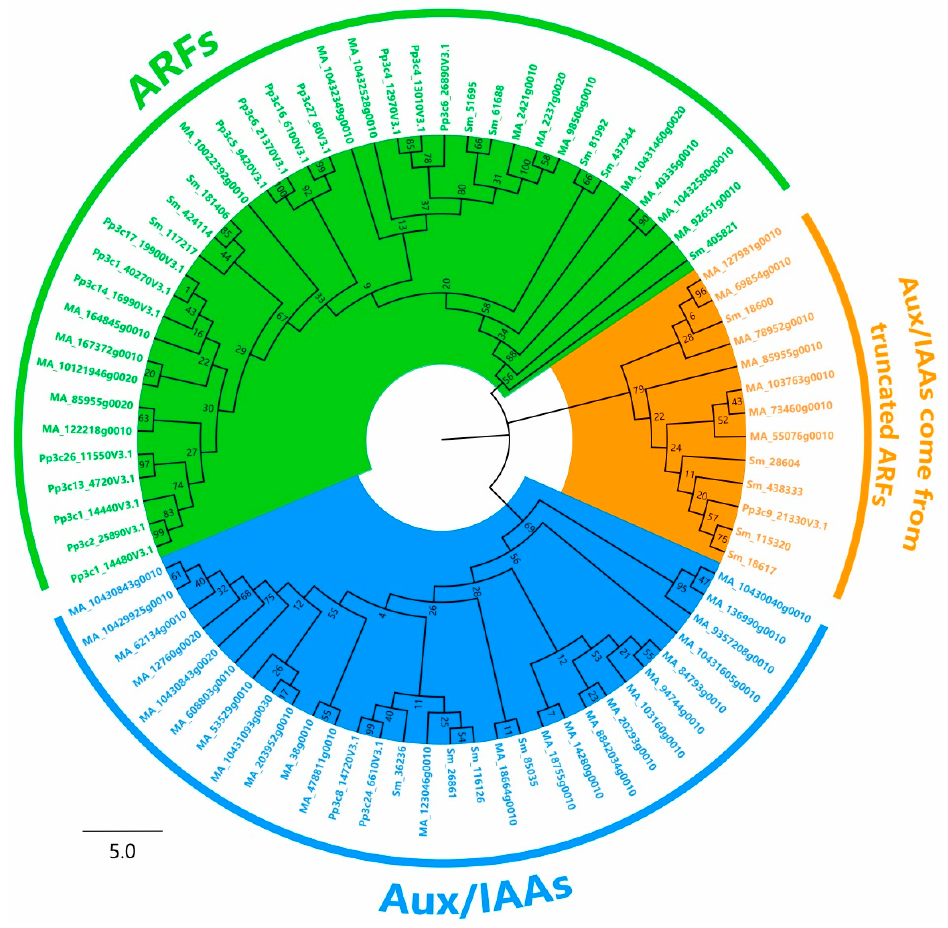
Figure 4. Phylogeny of Aux/IAAs and ARFs in Physcomitrella patens , Selaginella moellendorffii , and Picea abies . The deduced full-length amino acid sequences of Aux/IAA genes and ARF genes were